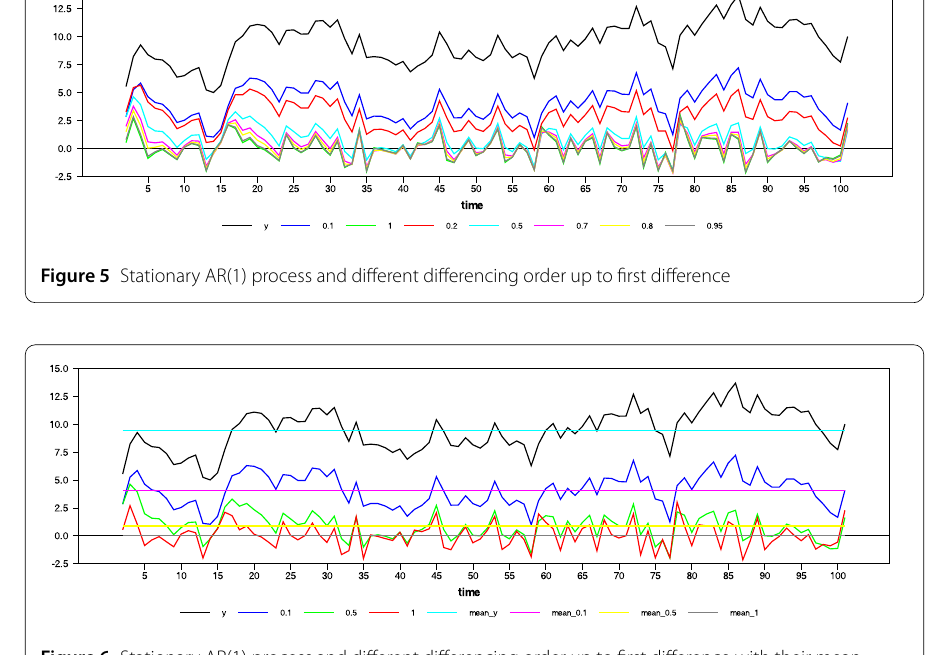
Figure 6 Stationary AR(1) process and different differencing order up to first difference with their mean